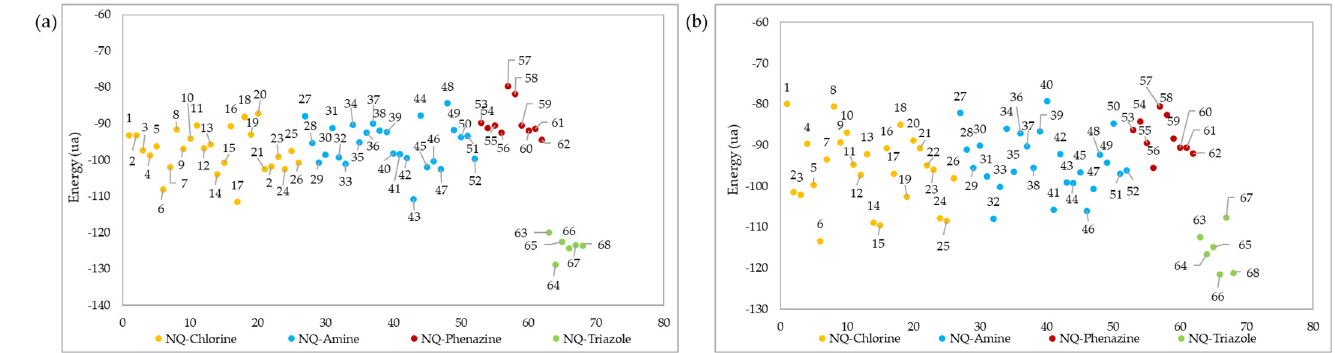
Figure 6. Ligand–protein docking energies of 1,4-naphthoquinone derivatives against ( a ) Tc TR and ( b ) Tc L α D receptors.